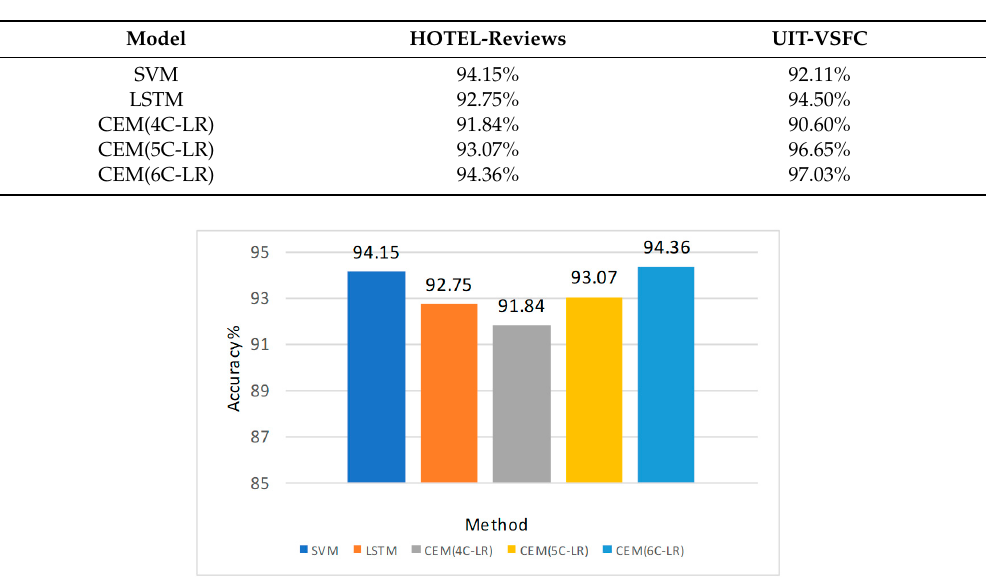
Figure 5. Results experimented on corpus of HOTEL-Review.